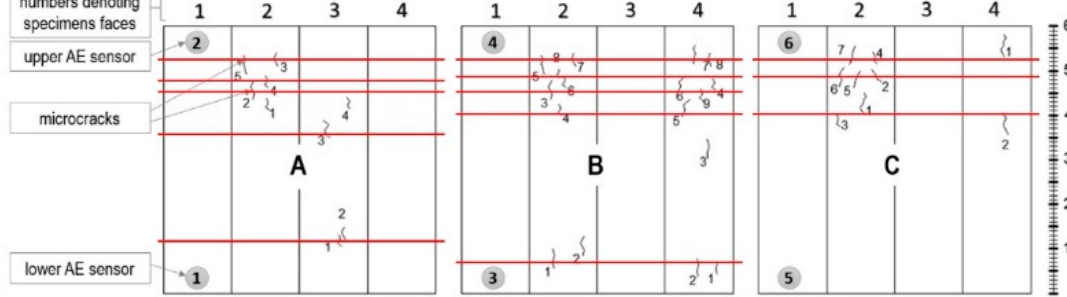
Figure 6. Surface microcrack distribution on sides of the W3 samples. Linear location of destructive processes III (AE signal class 3) in W3 samples obtained by the AE (Acoustic Emission) method is marked in red.